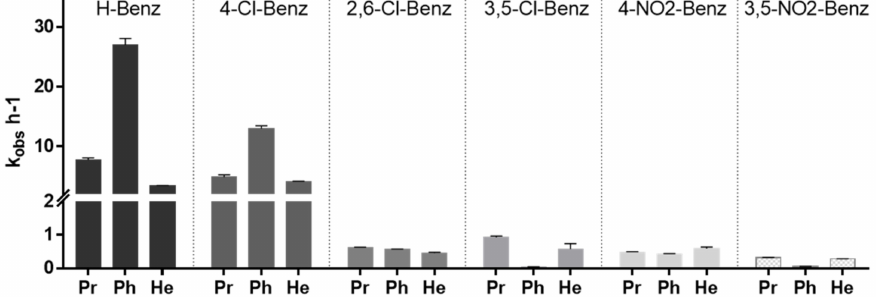
Figure 5. Pseudo first order rate constants for the activation by hydrolysis of the esters under study in M. smegmatis